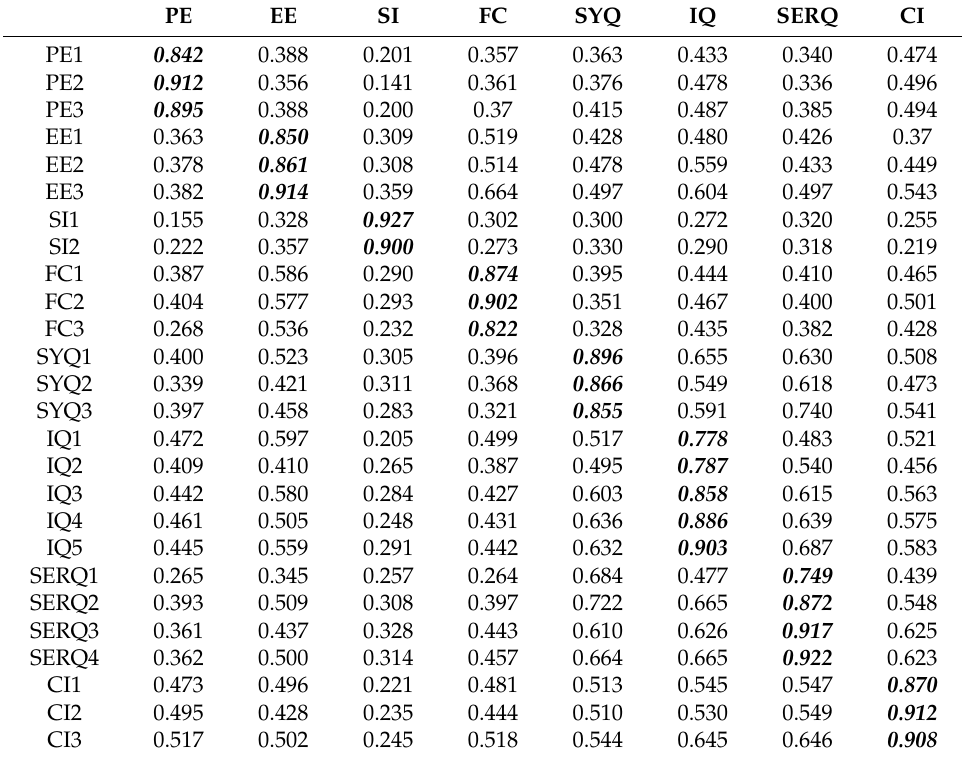
Table 4. Standardized factor loadings and cross-loadings for